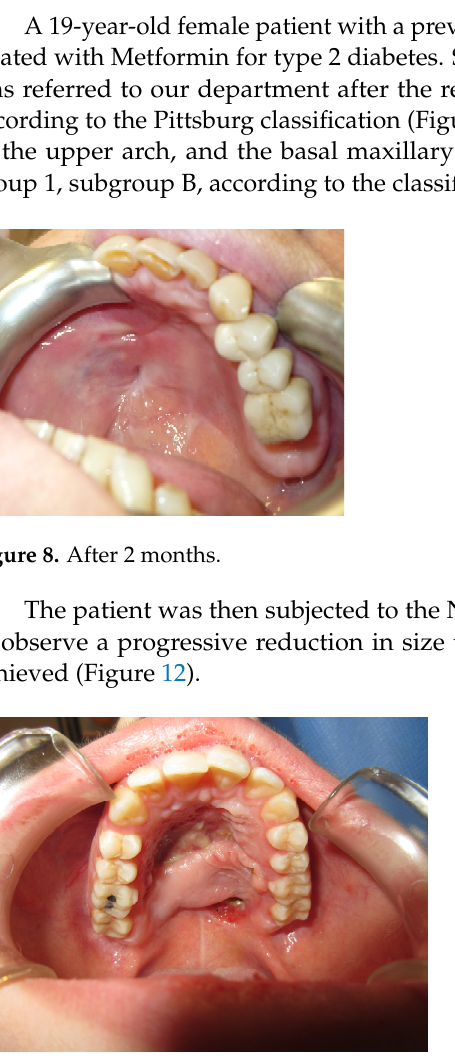
Figure 7. After one month.